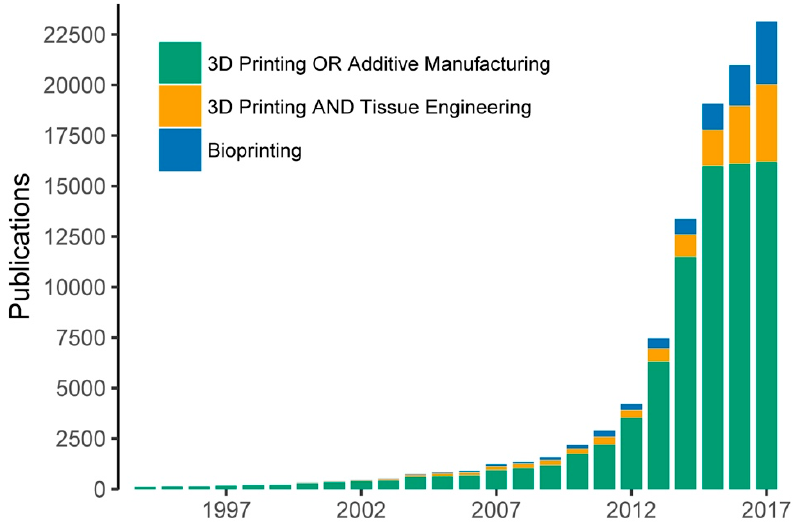
Figure 1. Evolution of bioprinting and 3D printing publications measured by the number of Google Scholar hits. The keywords utilized for the searching included: “3D printing” OR “additive manufacturing”, “3D printing” AND “tissue engineering” and “bioprinting”.